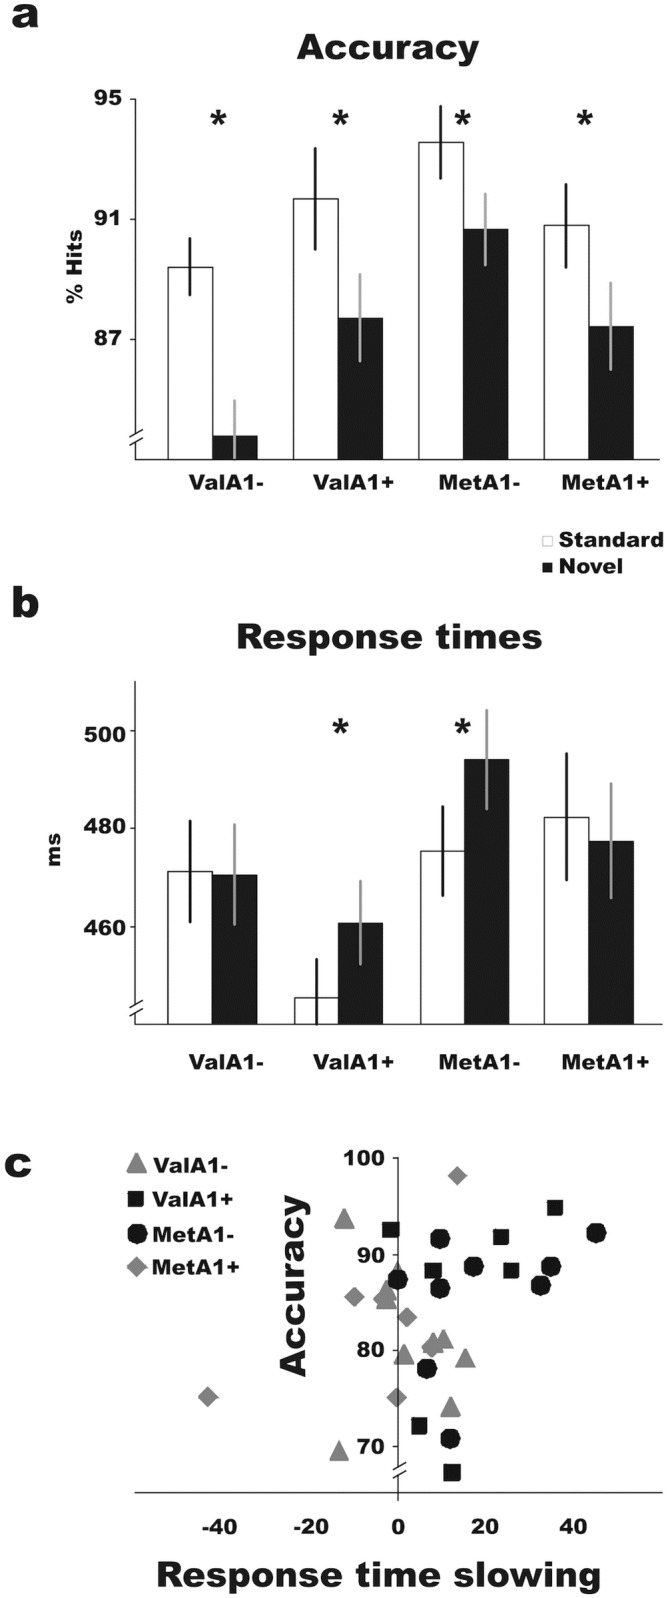
Task performance in all four groups.(a) Accuracy was lower in trials with novel sounds in comparison to those with standard sounds in all four groups (*, p<0.005). Notice the inverted-U shape of accuracy in the two trial types for the four groups arranged in the panel according to their levels of PFC-Striatum DA balance. (b) Response times in standard and novel trials (*, p<0.03). Notice that two groups displayed similar RT (i.e., ValA1- and MetA1+) in standard and novel trials, whereas the other two groups (i.e., ValA1+ and MetA1-) showed larger RT in novel than in standard trials. (c) Distribution of mean accuracy and RT slowing in all single individuals. Notice that the black symbols, representing individuals in the balanced groups, are mainly distributed on the upper right part of the plot, showing larger RT slowing after novel relative to standard sounds, but better mean accuracy than the unbalanced groups. In contrast, individuals from the unbalanced groups (white symbols) were distributed on the lower part of the graph as their accuracy was slightly worse, and along the Y axis because their RTs were not delayed by the novel sounds.